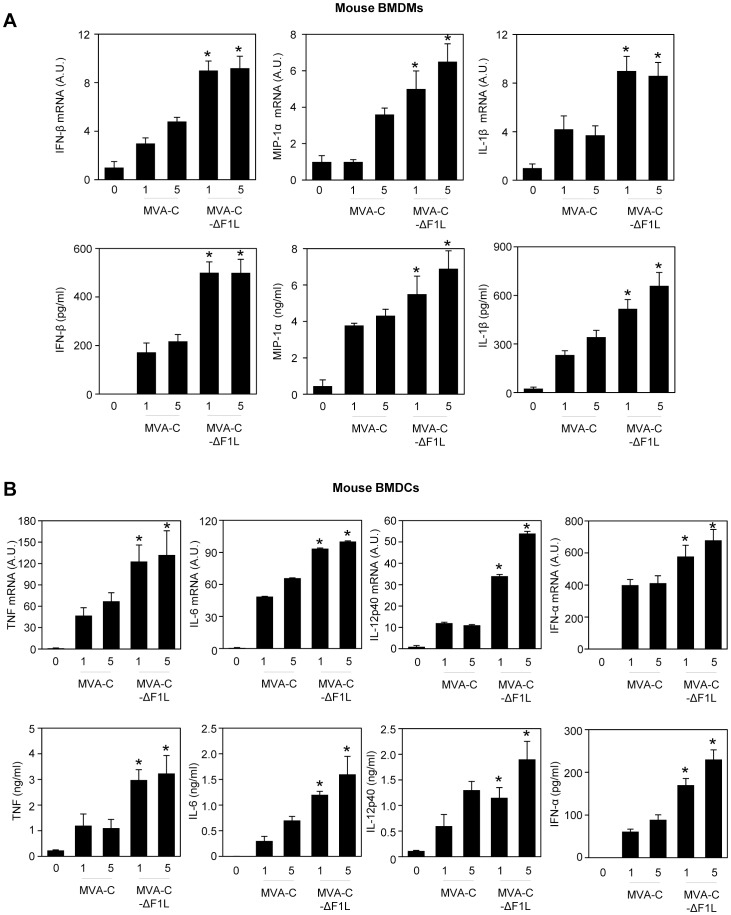
MVA-C-ΔF1L deletion mutant enhances the production of type I IFNs and cytokines in murine macrophages (A) and dendritic cells (B).BMDMs or BMDCs were mock-infected (0) or infected with MVA-C or MVA-C-ΔF1L at 1 or 5 PFU/cell for 6 hours (upper panels) or 24 hours (lower panels). IFN-α, IFN-β, IL-1β, TNF, IL-6, IL-12p40 and MIP-1α mRNA (upper panels) and protein (lower panels) levels were quantified by RT-PCR and ELISA, respectively. mRNA results are expressed as the ratio of the gene of interest to Hprt mRNA levels. A.U: arbitrary units. ELISA results are means ± SD of duplicate samples from one experiment and are representative of two experiments. * p<0.05 for all conditions comparing MVA-C-ΔF1L to MVA-C at the same MOI.